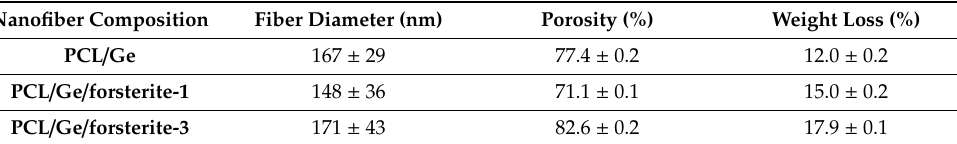
Table 2. Morphology characteristic of the electrospun sca ff olds.